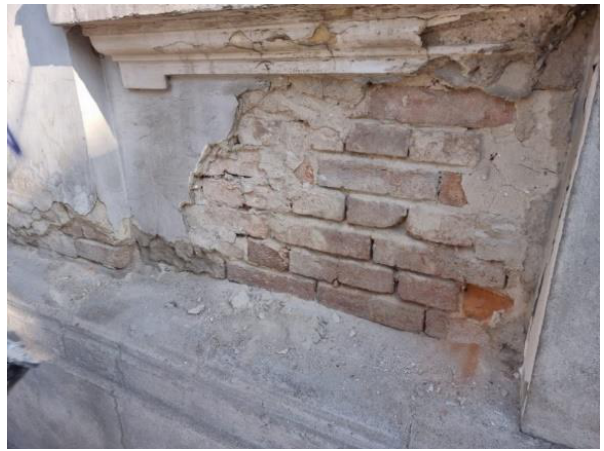
Figure 4. Plaster waste gathering from the brick support